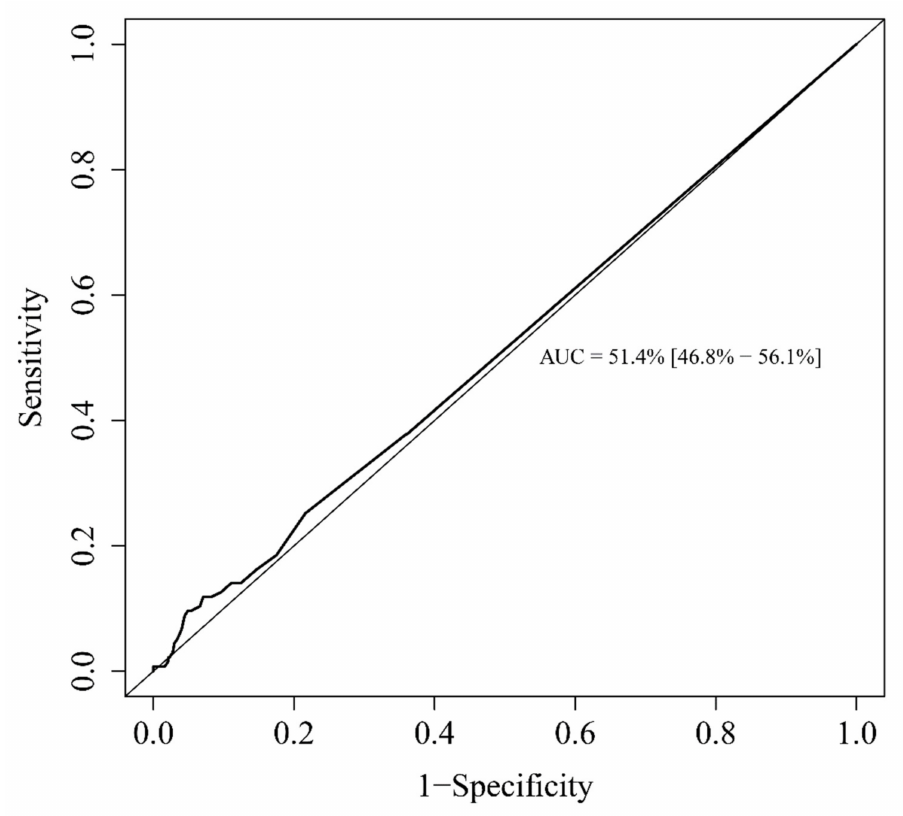
Figure 3. Receiver operating characteristics (ROC) curve for the ability of eosinophils to predict death. Abbreviation: ICU = intensive care